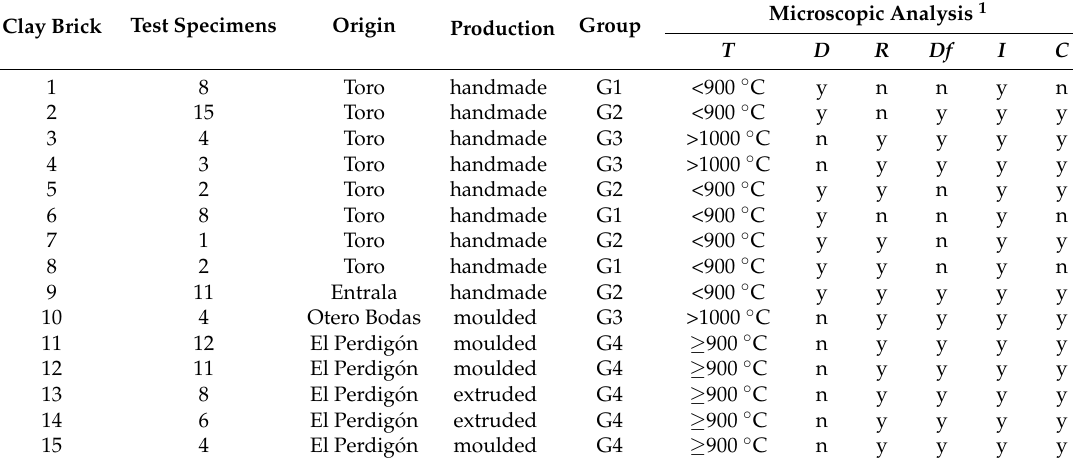
Table 1. Description of the specimens analysed in the